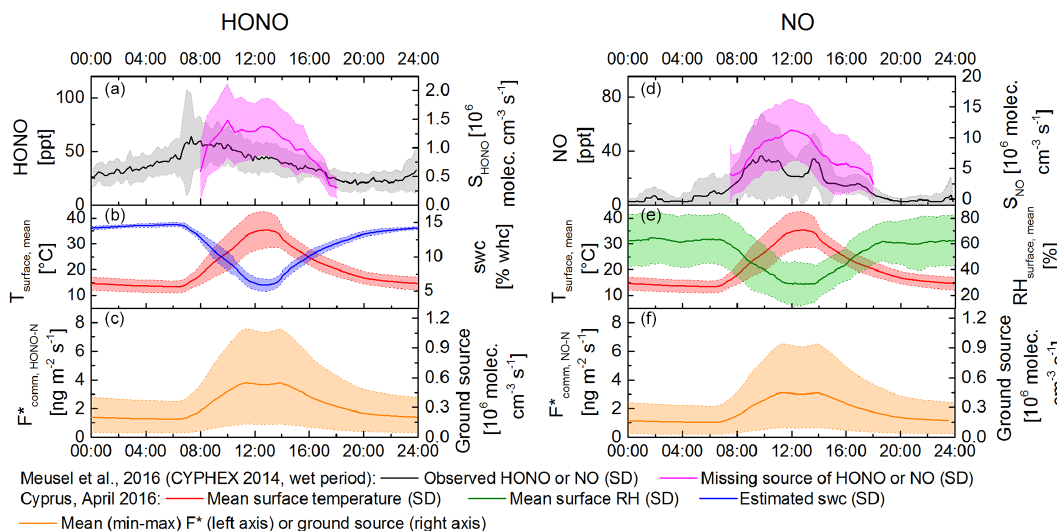
Figure 8. Diel pattern for HONO and NO emissions in comparison with the observed HONO concentrations and missing source during the CYPHEX 2014 campaign. Panels (a, d) show observed concentration of HONO and NO in black; missing source shown in pink. Panels (b, e) show mean surface temperature and mean surface humidity measured in April 2016 in Cyprus and estimated soil water content in red, green and blue, respectively. Panels (c, f) show the calculated mean F* (mean temperature) with the shaded area indicating the lower and upper